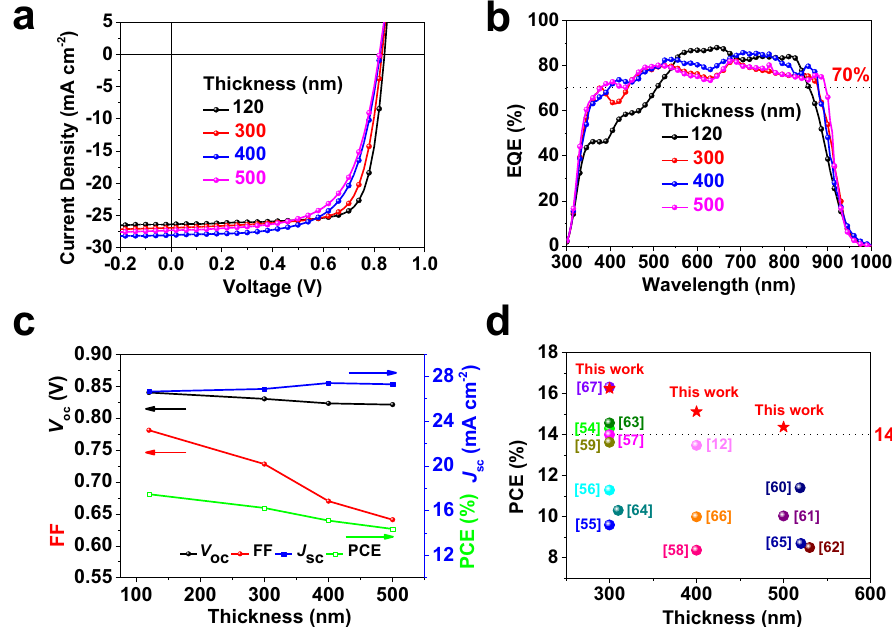
Fig. 5 The photovoltaic properties of thick G-BHJ OSCs. a J – V , b EQE curves of the optimal G-BHJ OSCs with different active layer thickness. c device performance parameters (PCE, J SC , V OC , and FF) versus the active layer thickness. d Comparison of our results with previously reported PCEs and thickness for both binary and ternary OSCs. The detailed material systems and device parameters of each point are provided in Supplementary Table